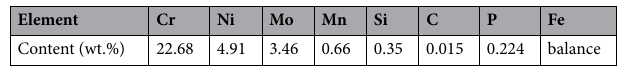
Table 1. 2205 DSS main chemical composition.